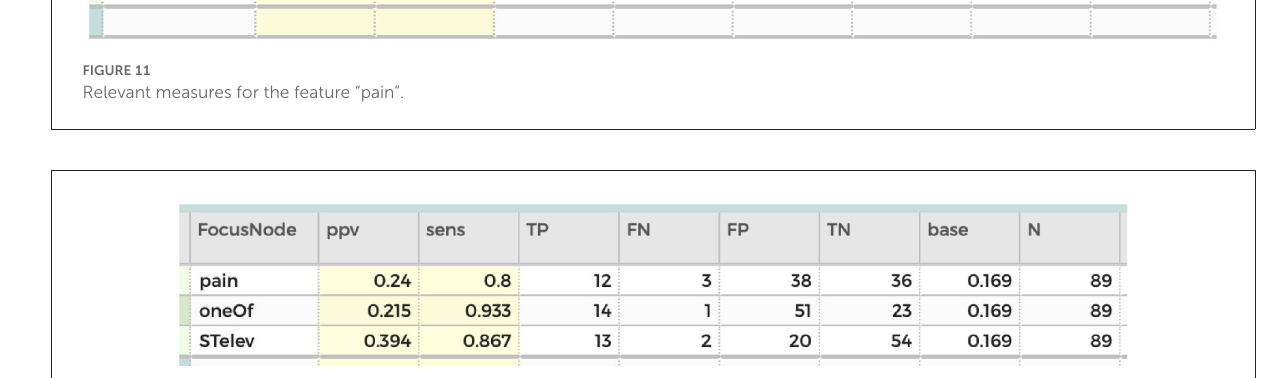
FIGURE12 Relevant measures for the three features considered.